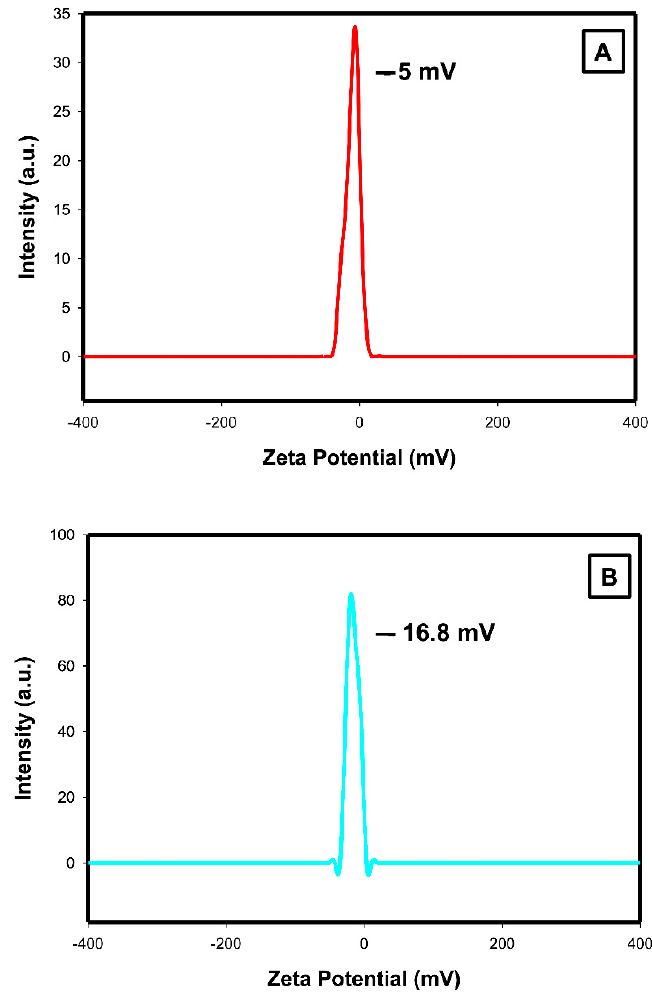
Figure 2. Zeta potential analysis of ( A ) AuNPs and ( B ) AuNPs-ALA.